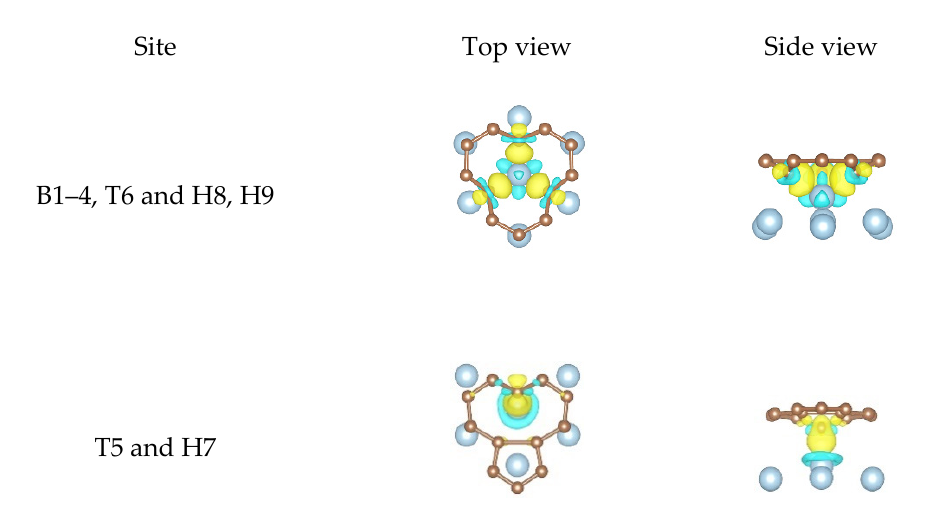
Figure 7. The local differential charge density plots at the SV graphene/Al (111) interface. The yellow/blue colors mark an increase/decrease of the charge density, respectively. Iso surfaces correspond to 6 × 10 − 3 e/Å 3 .